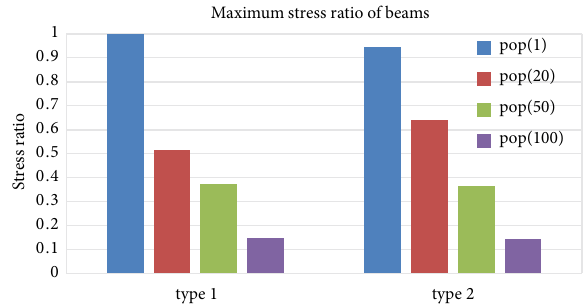
Fig. 5. Stress ratio of the first model beams groups